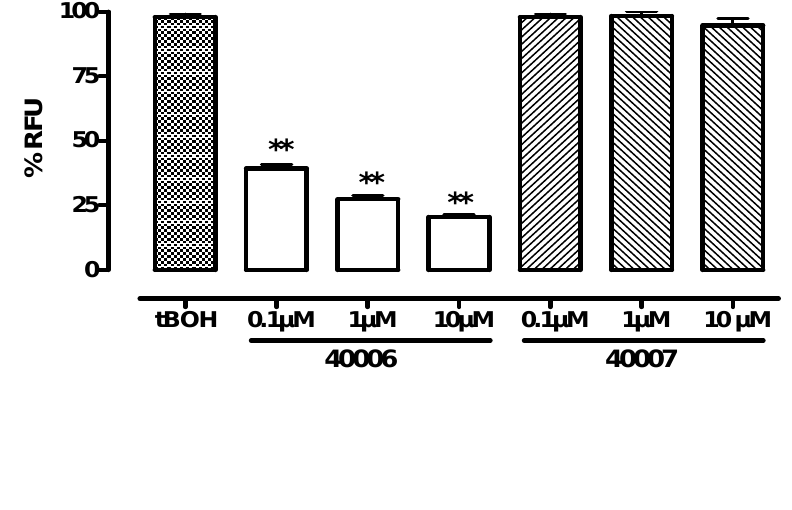
Figure 1. Effect of compounds 40006 and 40007 on ROS production by tBOH-induced J774.A1 macrophages. ROS reaction was determined by measuring the converting reaction to DCF. ROS production were expressed as mean ± S.E.M. of of DCFH 2